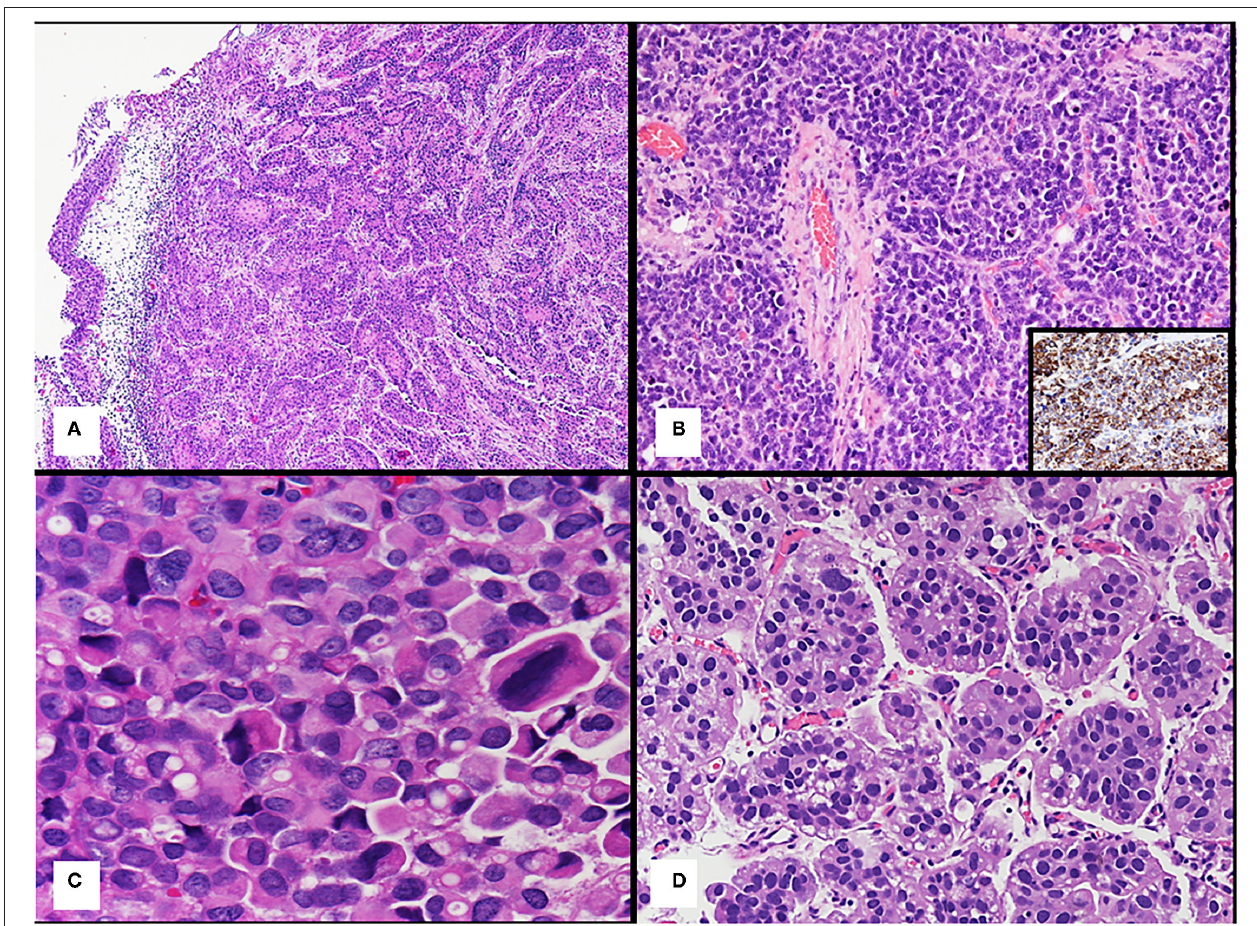
FIGURE 2 | (A) Urothelial carcinoma with squamous divergent differentiation. (B) Bladder neuroendocrine tumor; the inset shows positive immunohistochemistry staining for synaptophysin of the tumor. (C) Plasmacytoid urothelial carcinoma. (D) Micropapillary urothelial carcinoma.